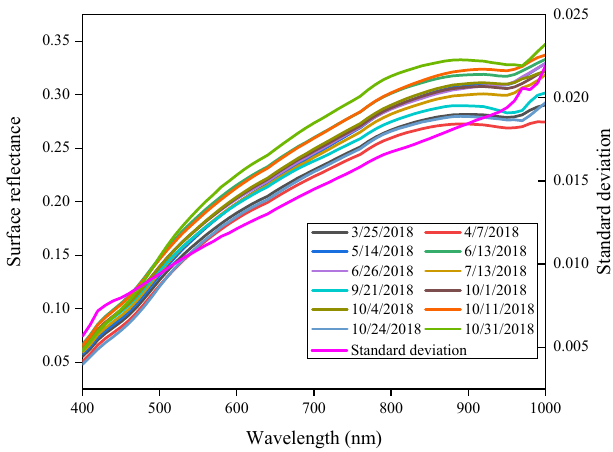
Figure 4. Retrieved surface reflectance of desert target covering the spectral range of Sentinel-2B/MSI on the study dates.